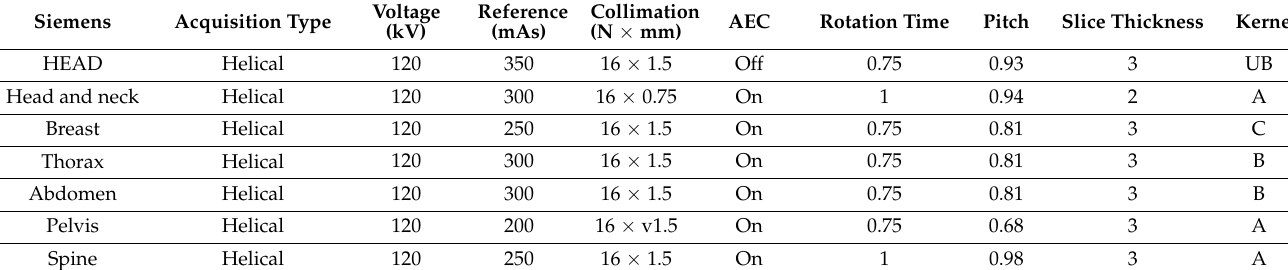
Table 8. Scanning parameters of the simulation protocols in Philips CT unit.